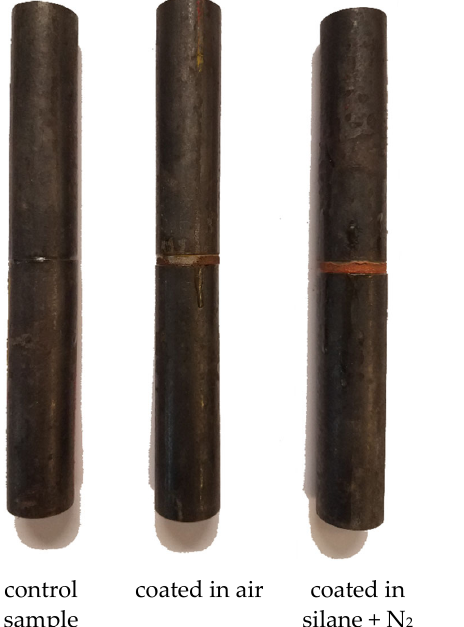
Table 1. Sample set codes of the adhesive tensile strength specimens. Coating Specimens in Accordance to DIN EN ISO 14916